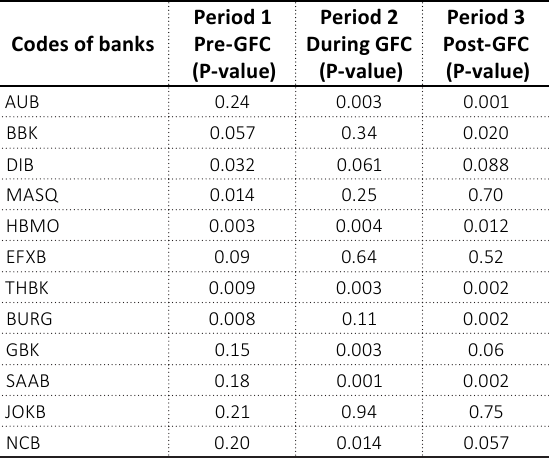
Table 5. Wilcoxon rank-sum test for the emotional words of the joy and sadness categories (One Tail Two-Sample) H2: The emotional words of the joy category dominate the emotional words of the sadness category in banks’